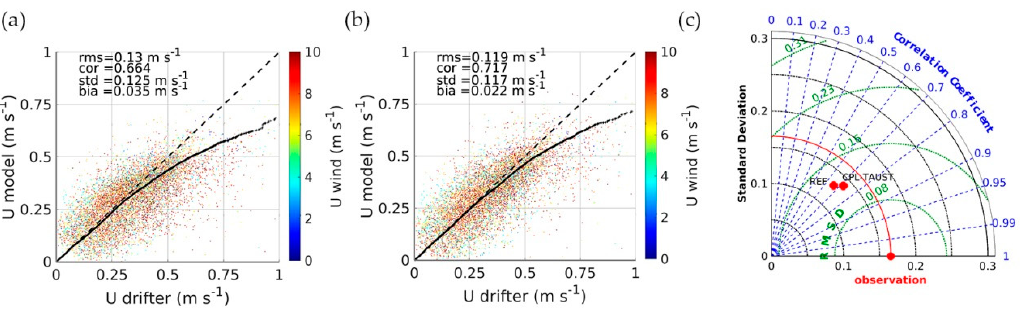
Figure 3. Scatter plots of velocity magnitude for the REF experiment ( a ) and CPL-TAUST experiment ( b ) of the HZG drifters vs. model data colored to wind velocity component and the quantile–quantile ( q - q ) plot in black. The black dashed line is the diagonal. Taylor Diagram of the velocity magnitude ( c ).